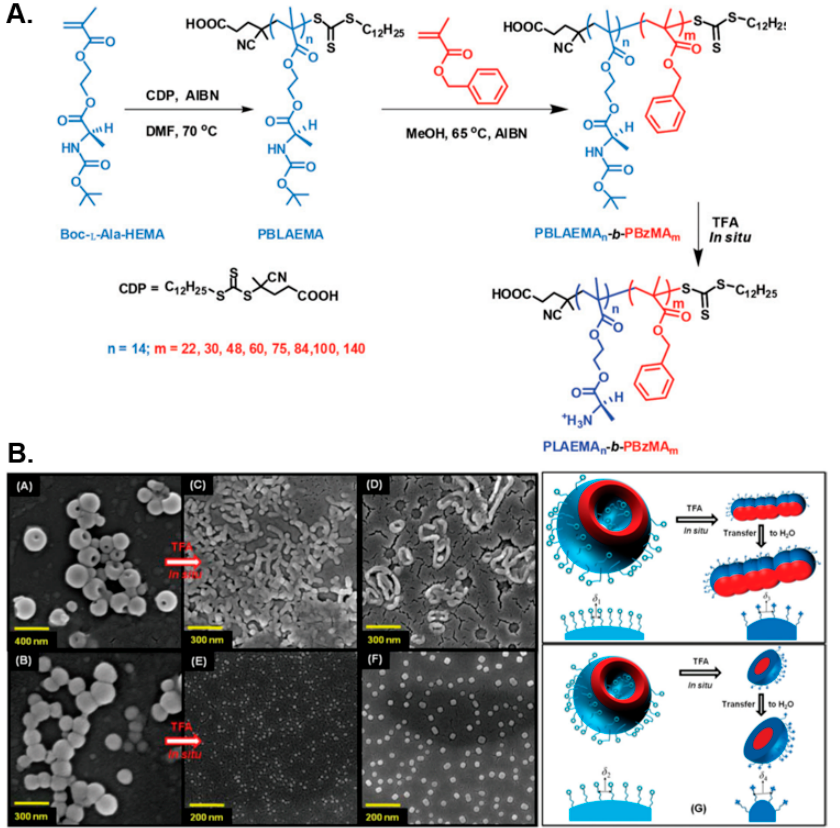
Figure 6. ( A ) Synthesis of PBLAEMA- b -PBzMA diblock copolymer nano-objects via alcoholic RAFT- mediated PISA and subsequent Boc-group cleavage for the preparation of respective PLAEMA- b -PBzMA nanostructures. ( B ) Representative SEM images of PBLAEMA- b -PBzMA vesicles and their corresponding lower-order nano-object morphologies in methanol and water, following in situ Boc-group deprotection of PBLAEMA, along with a schematic illustration of the process. Reproduced with permission from reference [102]. Copyright 2015 Royal Society of Chemistry.